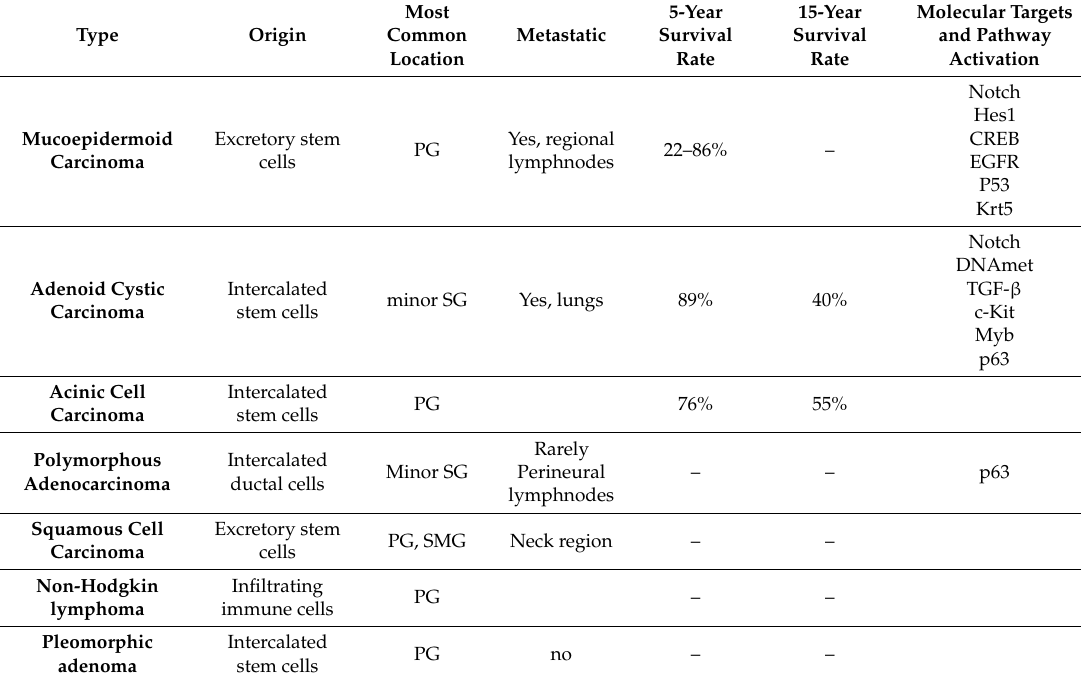
Table 1. Salivary gland tumours. Salivary gland tumours are heterogeneous and can derive from di ff erent type of cells in the tissue. Presented here are the most common malignancies a ff ecting the salivary